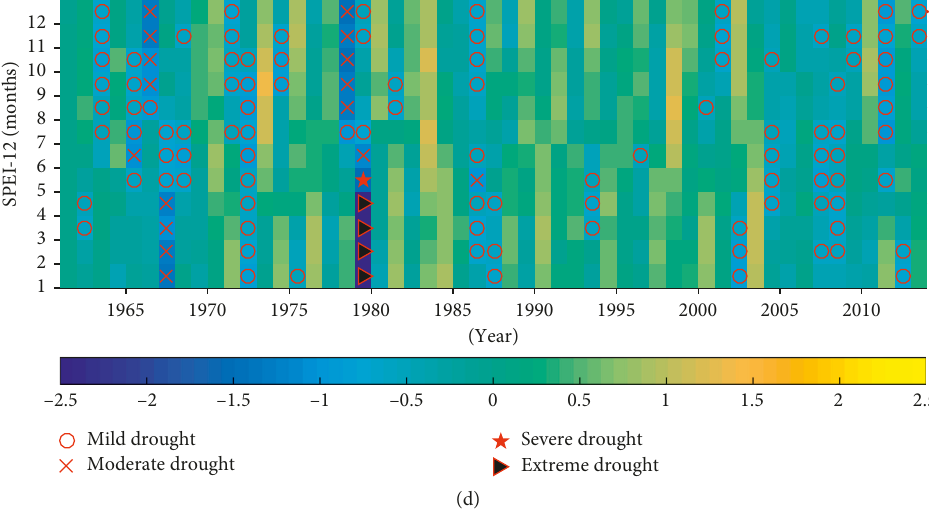
Figure 3: Monthly contours of the (a) SPEI-1, (b) SPEI-3, (c) SPEI-6, and (d) SPEI-12 values and the drought events of different severity grades during 1961–2013. Note . SPEI-1, SPEI-3, SPEI-6, and SPEI-12 represent the SPEI values calculated on timescales of 1, 3, 6, and 12